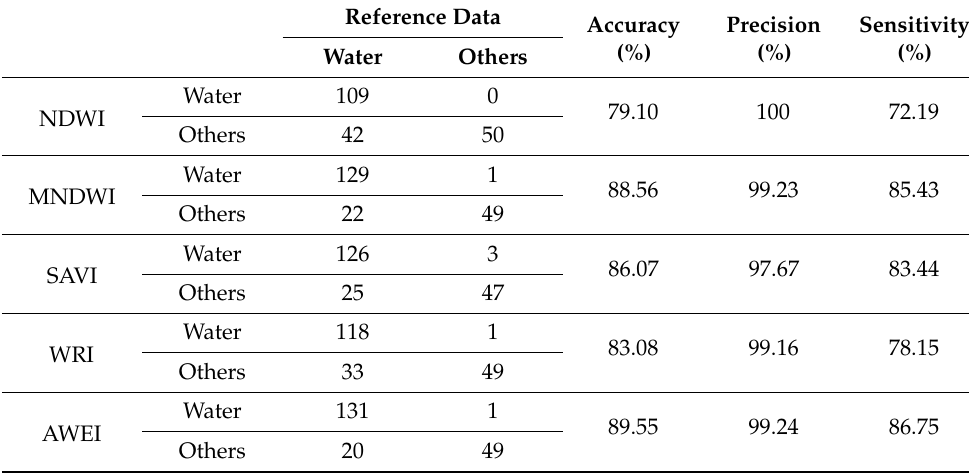
Table 3. Confusion matrix of the results obtained from water indices in 2015.